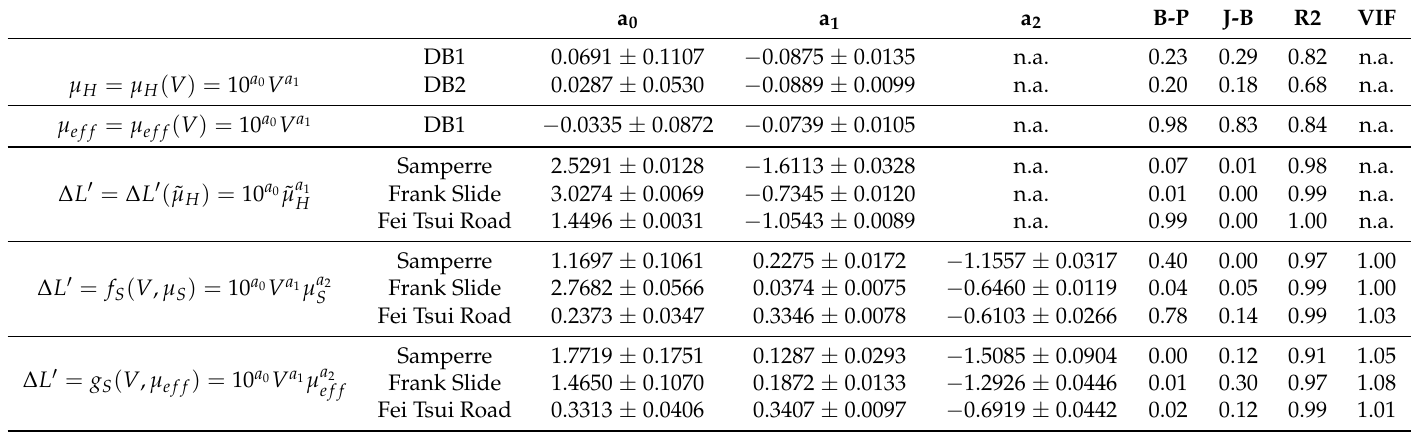
Table A1. Results of the intermediate power laws. We give the coefficients along with the 95% confidence interval. We also indicate the adjusted R 2 and the p -values of the Harvey-Collier test (HC, linearity hypothesis), of the Jarque-bera test (J-B, normality of residuals hypothesis) and of the Breush-Pagan test (B-P, homoscedasticity hypothesis). Low p -values (typically, less than 0.05) indicate that the hypothesis is not verified. The Variance Inflation Factor (VIF) measures colinearity between a 1 and a 2